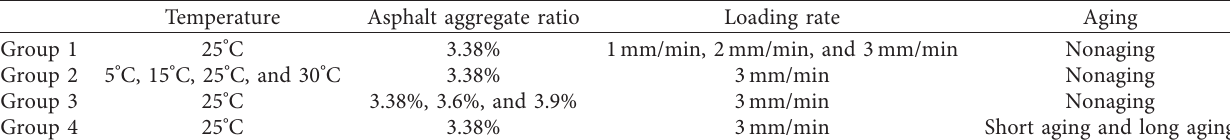
Table 5: The specific test